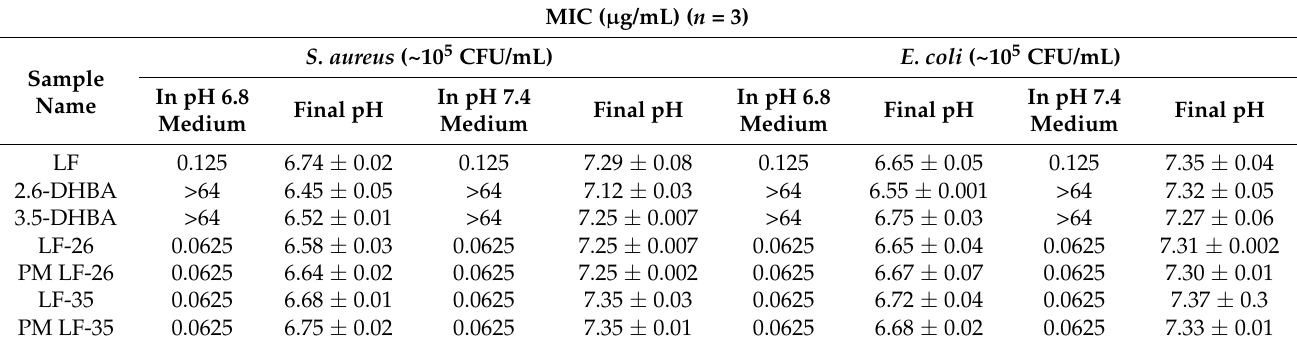
Table 5. Minimum inhibition concentration (MIC) of LF-26 and LF-35 compared to constituents. MIC ( µ g/mL) ( n =